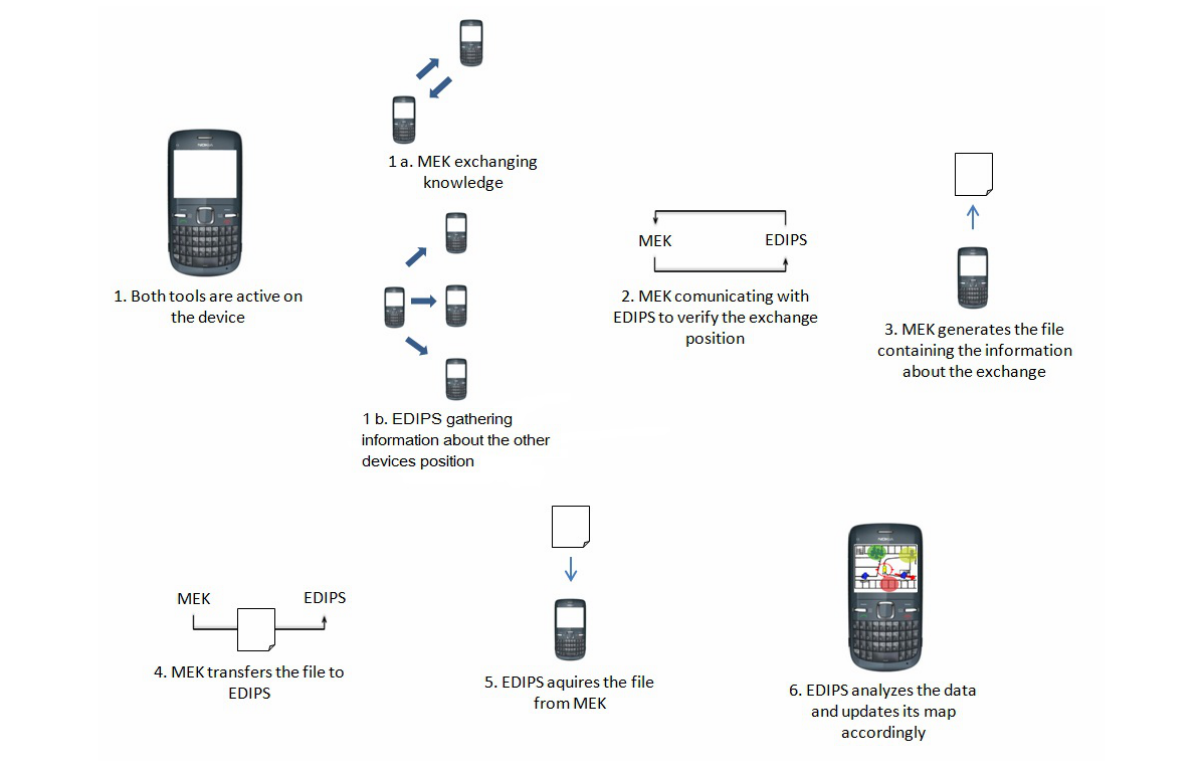
Figure 7. Integration of the